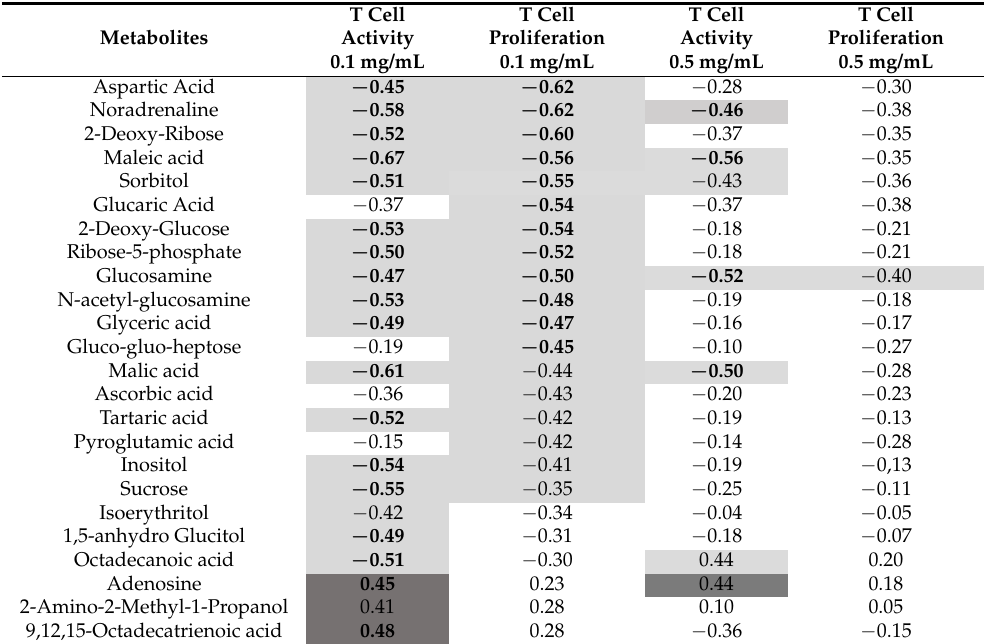
Table 3. The correlation between the relative abundance of metabolites and their effect on T cell activity and T cell